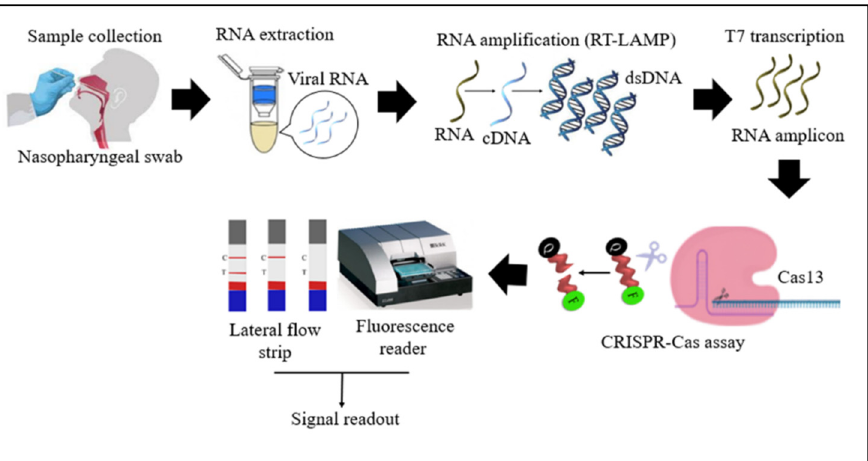
Figure 4. Schematic diagram of RT-LAMP CRISPR-Cas13-based detection of SARS-CoV-2. Samples (nasopharyngeal swabs) were collected from symptomatic and asymptomatic individuals, and viral RNAs were extracted. With the RT-LAMP step, viral RNAs are first converted into cDNAs, which are subsequently amplified. An additional step was required for Cas13-based detection: T7 transcription to convert DNA amplicons to RNA amplicons, which were then targeted in Cas13-based detection; the results of the test were visualized via colorimetry or a fluorescence assay.